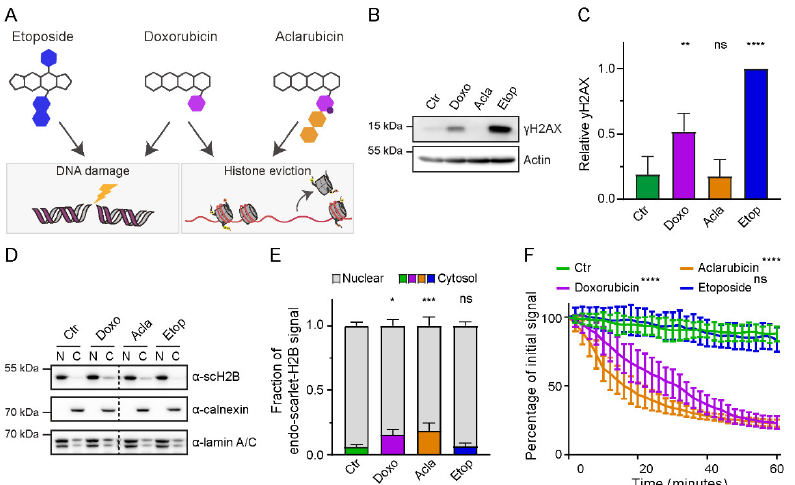
Figure 2. Mechanism of action of anthracycline drugs. ( A ) Schematic overview of the DNA damage (via targeting topoisomerase II) and chromatin damage (via eviction of histones) activity of the three anthracycline drugs used in this study. ( B ) Endogenously tagged scarlet-H2B U2Os cells were treated for 2 h with 10 µ M of the indicated drugs. γ H2AX levels were examined by Western blot, and actin was used as a loading control. ( C ) Quantification of the γ H2AX levels normalized to actin. Ordinary one-way ANOVA with multiple comparisons; ns—not significant; ** p = 0.0052; **** p < 0.0001. ( D ) Endogenously tagged scarlet-H2B U2Os cells were treated for 1 h with 10 µ M of the indicated drugs. Cells were fractionated, and the nuclear versus cytosolic fraction of H2B was examined by Western blot. Calnexin was used as cytosolic marker, and lamin A/C was used as nuclear marker. ( E ). Quantification of the nuclear versus cytosolic H2B signal from four independent experiments is plotted. Two-way ANOVA with multiple comparisons; ns—not significant; * p = 0.0109; *** p = 0.0007. ( F ). Quantification of the release of fluorescent PAGFP-H2A from the photoactivated nuclear regions upon administration of the indicated drugs. Ordinary one-way ANOVA with multiple comparisons; ns—not significant; **** p <